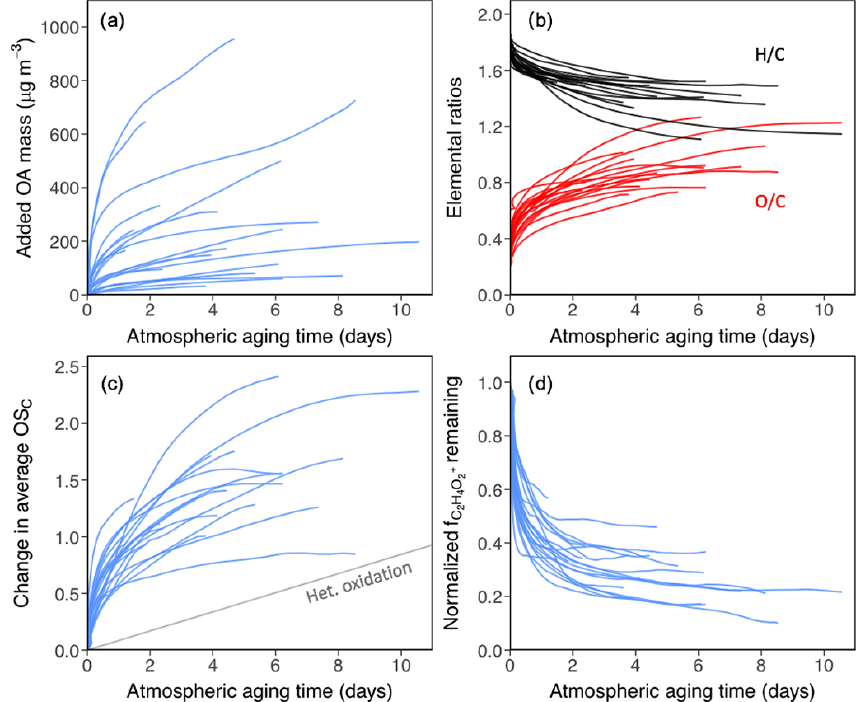
Figure 1. Changes in OA mass and composition as a function of aging time, assuming an atmospheric [OH] of 1 . 5 × 10 6 moleccm − 3 . Each line represents a separate aging experiment. (a) Increase in OA mass with oxidation, showing variable SOA across all experiments. (b) Elemental ratios (red: O / C, black: H / C). (c) Change in OS C ; reference line shows average change due to heterogeneous oxidation of laboratory flow tube experiments for comparison (Kroll et al., 2015). (d) Normalized fraction of AMS organic signal due to the C 2 H 4 O + fragment ion, a common primary biomass burning OA tracer indicative of levoglucosan and related